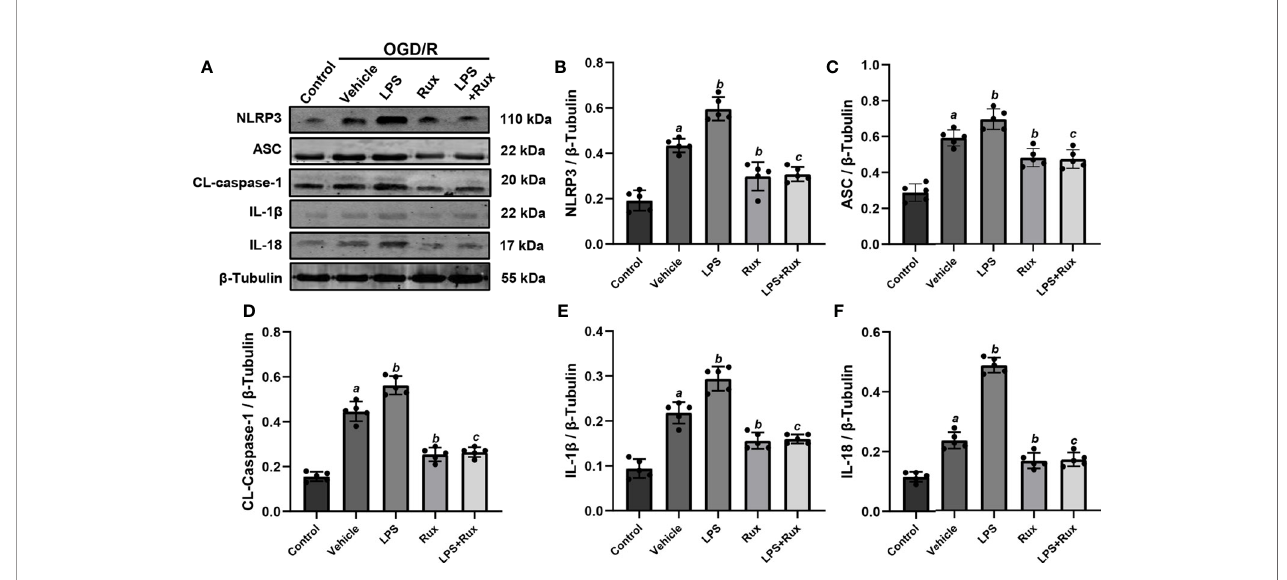
FIGURE 10 | Administration of Rux reduced NLRP3 in fl ammasome activation in HT22 cells after OGD/R. (A) Representative western blots showing NLRP3, ASC, CL-caspase-1, IL-1 b and IL-18 at the protein level. (B – F) Quanti fi cation results of NLRP3, ASC, CL-caspase-1, IL-1 b and IL-18 expression at the protein level. Means ± SD. n = 5/group. a P < 0.01 versus control; b P < 0.05 versus OGD/R + vehicle; c P < 0.05 versus OGD/R + LPS.